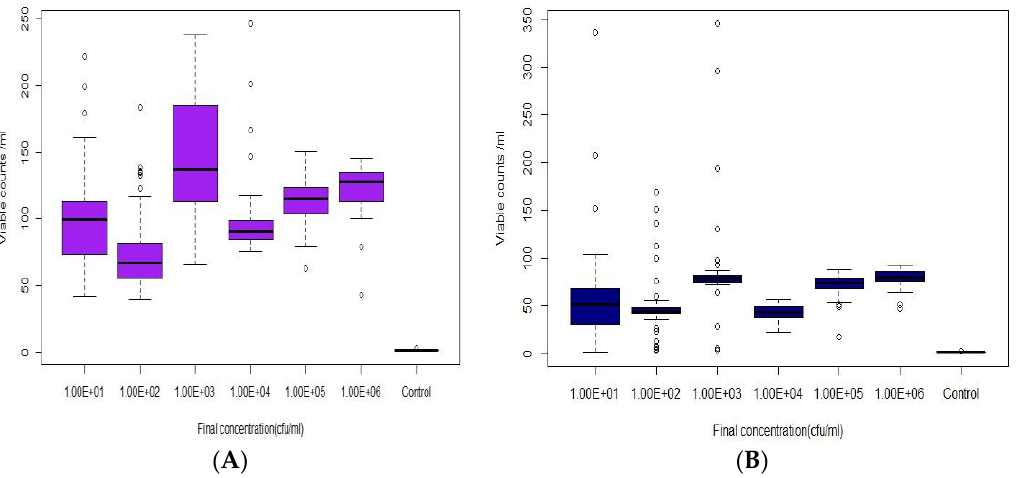
Figure 4. The sensor B response to E. coli spiked in Filtered tap water: ( A ) with TSB growth media (dirty) and ( B ) Washed cells (clean).